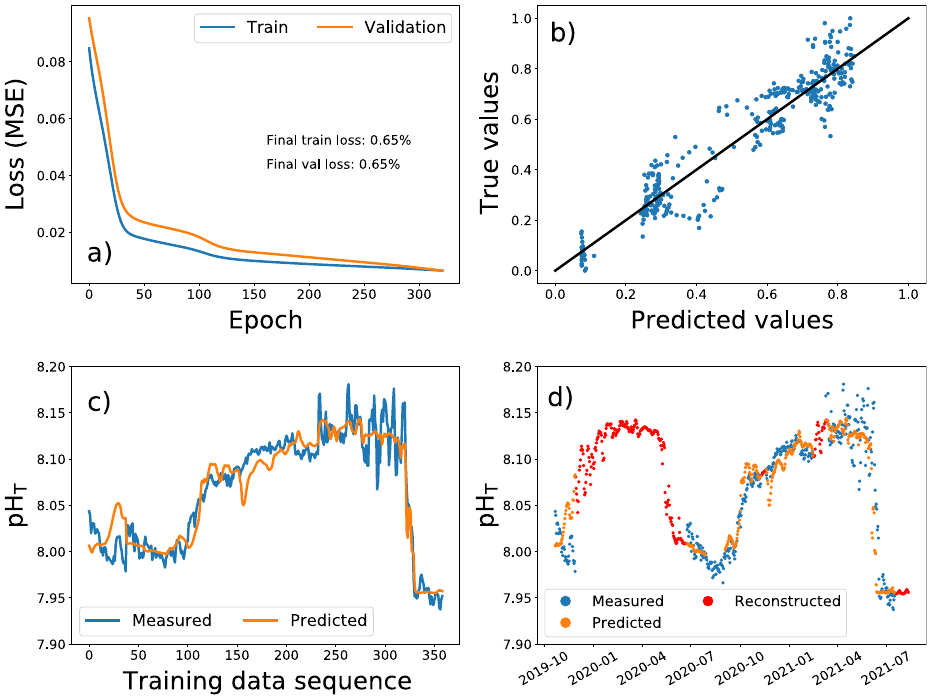
Figure 3. Bidirectional LSTM Neural Network model applied to fill the gaps in the pH T time series in Cabrera: ( a ) training process monitoring loss for both training and validation sets, ( b ) Predicted pH T values against their true values where the black line is the reference for perfect prediction, ( c ) Predicted pH T time series in the training process (orange) and ground truth series (blue) and ( d ) Gaps in the pH T time series filled with the trained model (red), while measured pH T are shown in blue and predicted data in the training process shown in